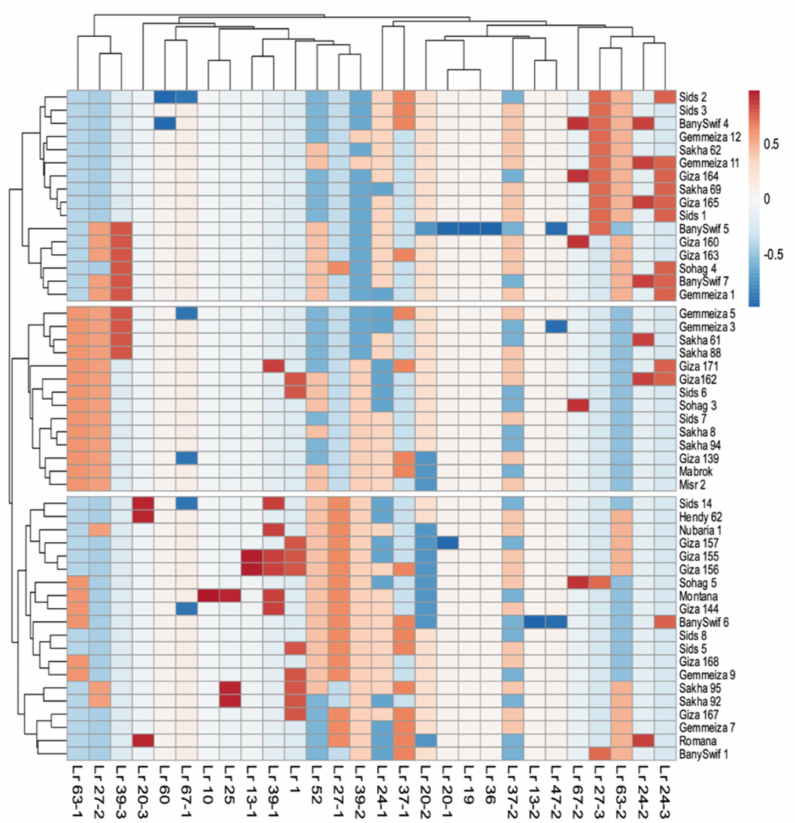
Figure 1. Two-dimensional heatmap showing the clustering of the 50 wheat varieties based on the presence of Lr genes’ and varieties’ performance revealed grouping into three distinct groups. Rows represent the 50 wheat genotypes and columns represent the Lr genes/alleles.